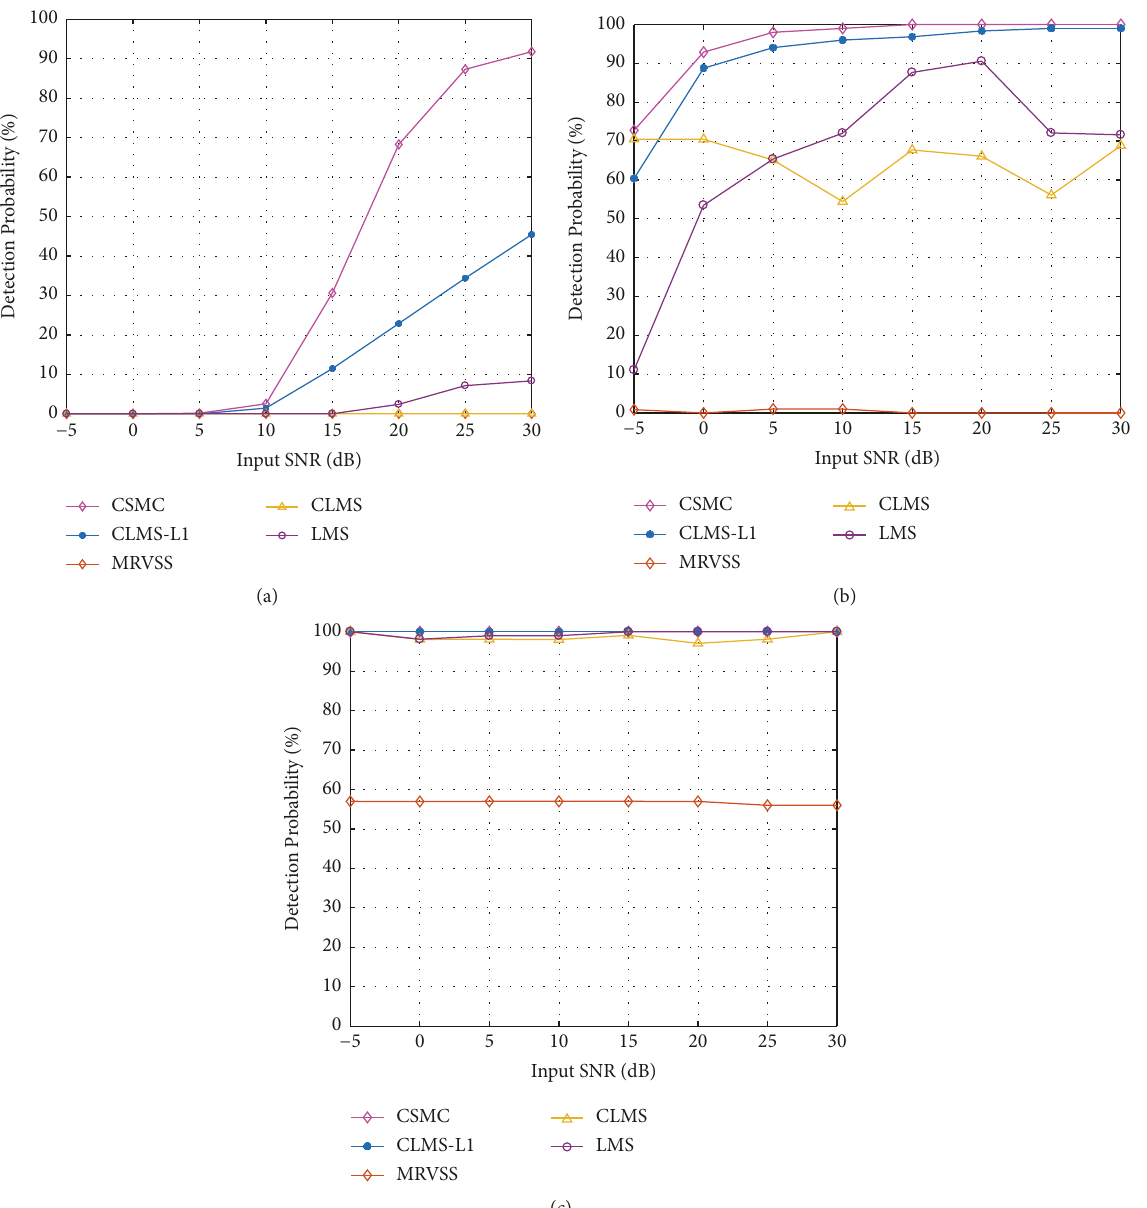
Figure 6: Acquisition performance in terms of detection probability in presence of the alpha noises of different impulsive level: (a) 𝛼 = 1.05 ; (b) 𝛼 = 1.45 ; (c) 𝛼 = 1.85